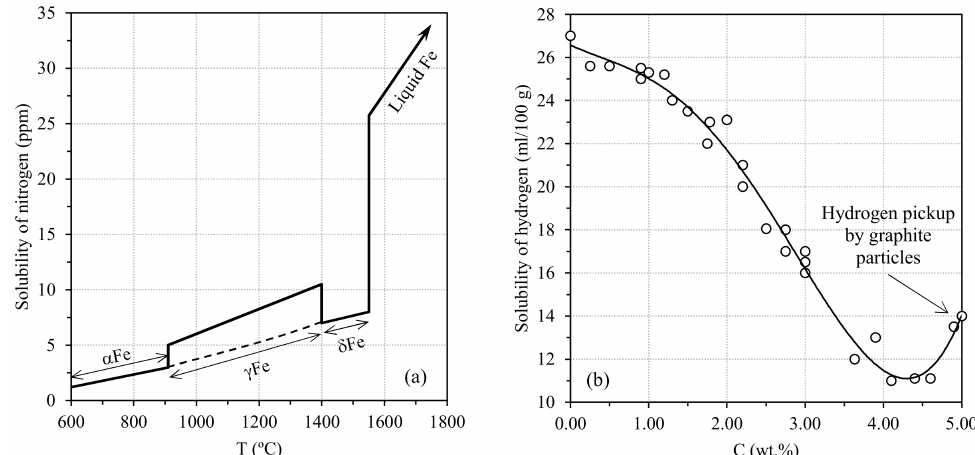
Figure 6. ( a ) Solubility of hydrogen in pure iron at one atmosphere pressure and ( b ) effect of carbon on hydrogen solubility at 1550 ◦ C in liquid Fe-C alloys. (Both graphs have been adapted with permission from ref. [8]. Copyright 1983